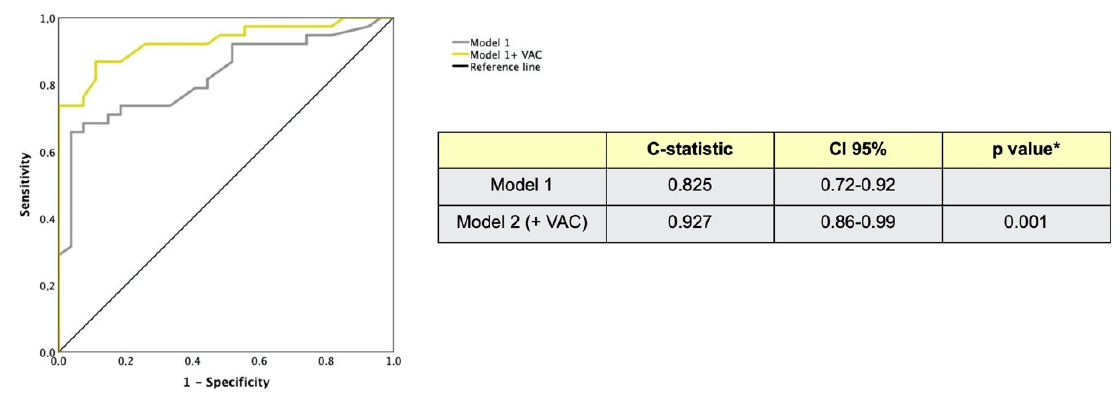
Figure 3. Receiving operating curves in model 1 and model 2 (including VAC > 0.63) for MACEs. C-statistic improves adding VAC > 0.63 in the multivariable model * p value is derived from comparison of model 1 to model 1 plus VAC > 0.63 (model 2).